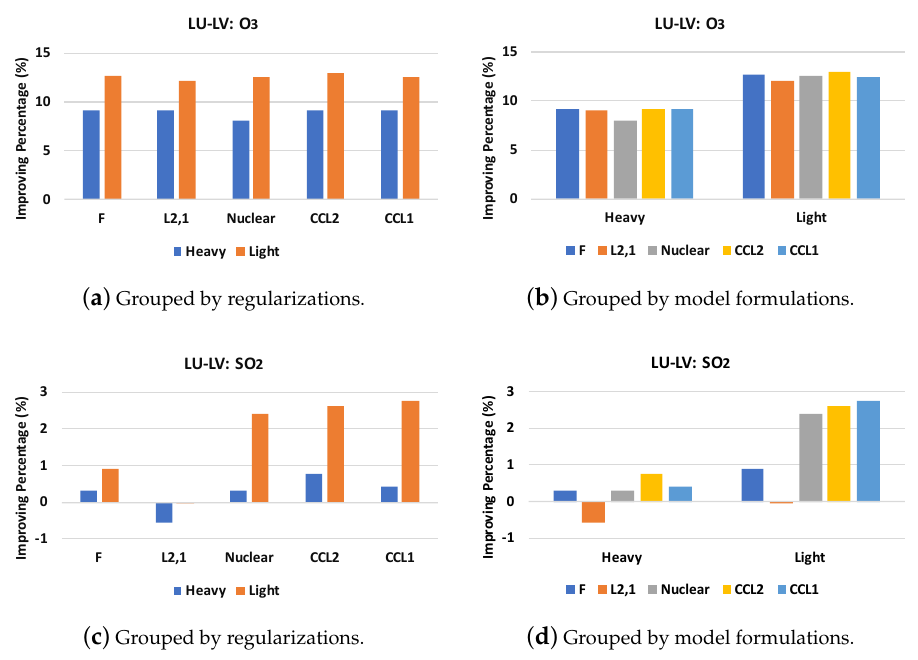
Figure 2. Improvement of different methods over the baseline method for Lewis University–Lemont Village (LU–LV) dataset.